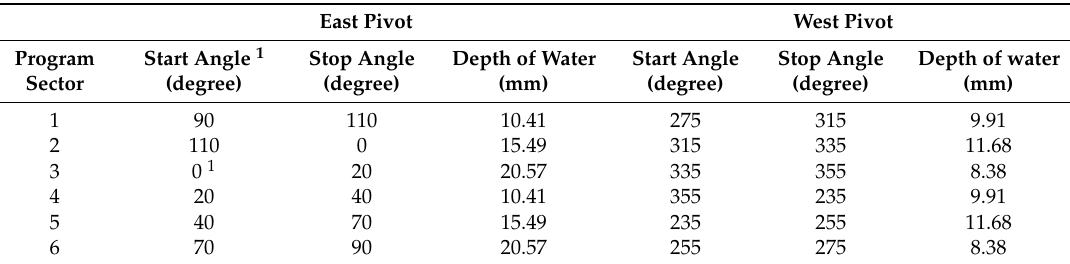
Table 1. Detailed information on the supplemental irrigation programs for the two center pivots within the 73-ha supplemental irrigation field that is located in southwestern Dyer County in west Tennessee for one revolution.